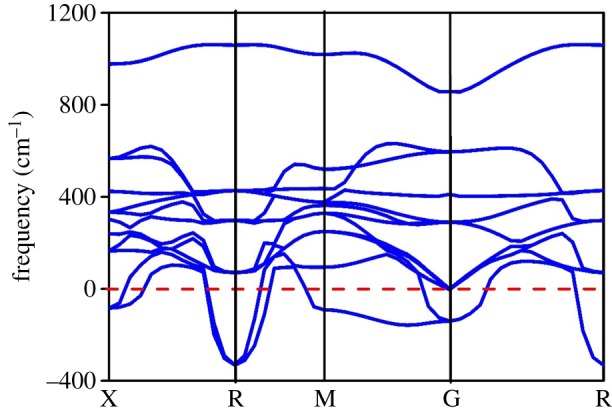
Phonon dispersion diagram for WO3.